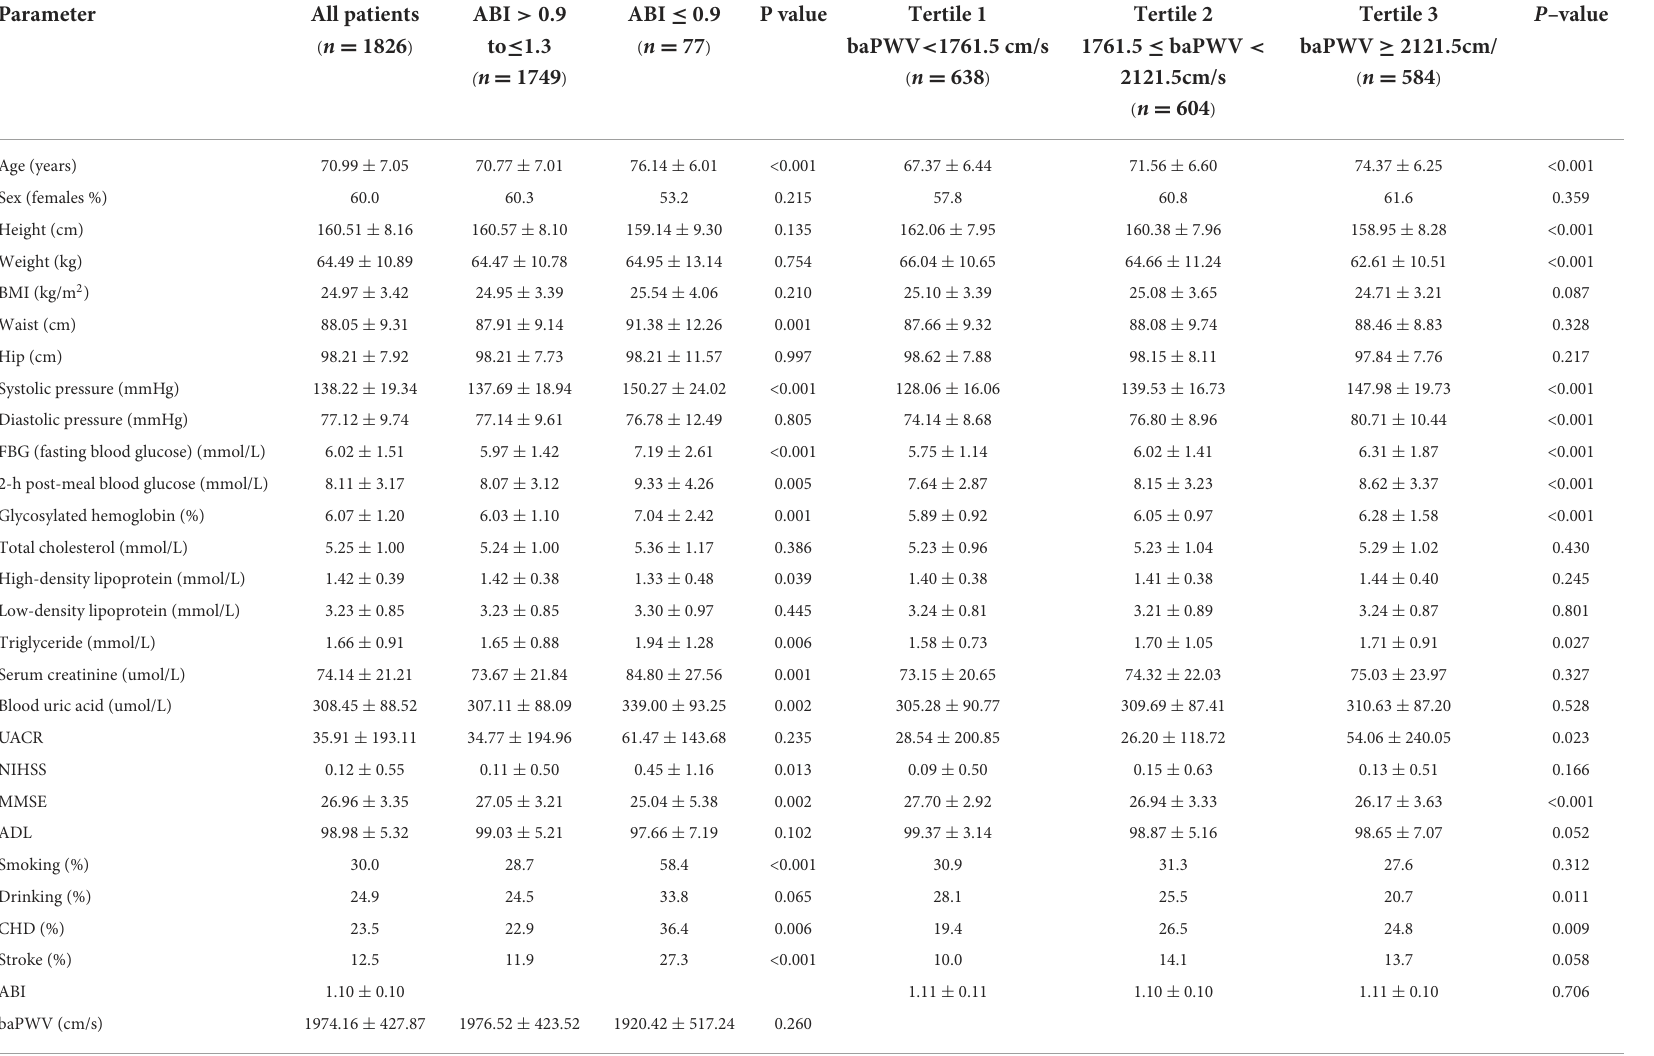
TABLE 1 Baseline characteristics of the study population (all men and women), by categories of ABI and baPWV.